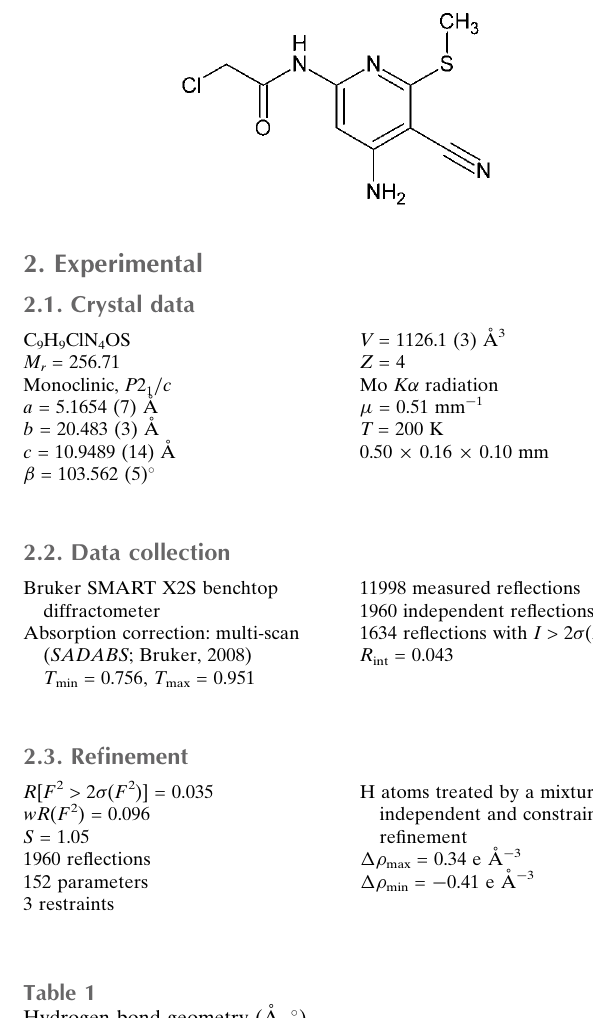
Hydrogen-bond geometry (A˚ , (cid:2)